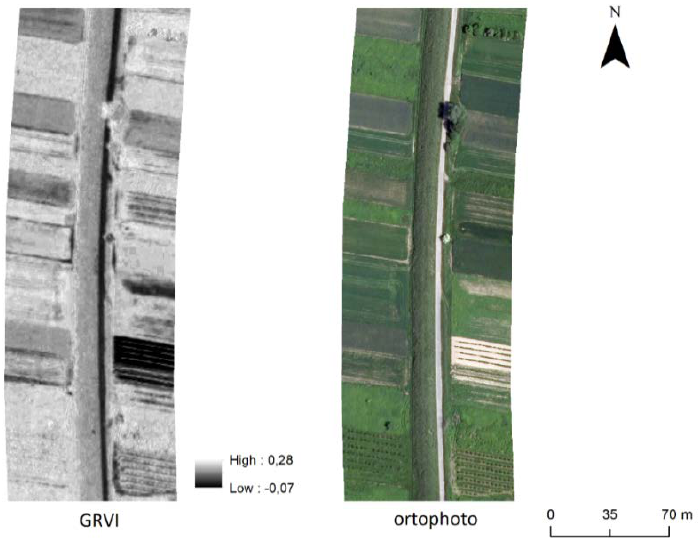
Figure 5. Example of GRVI calculated from the aerial RGB images compared with the orthophoto (aerial images: June 2015, UAS images: May 2017).